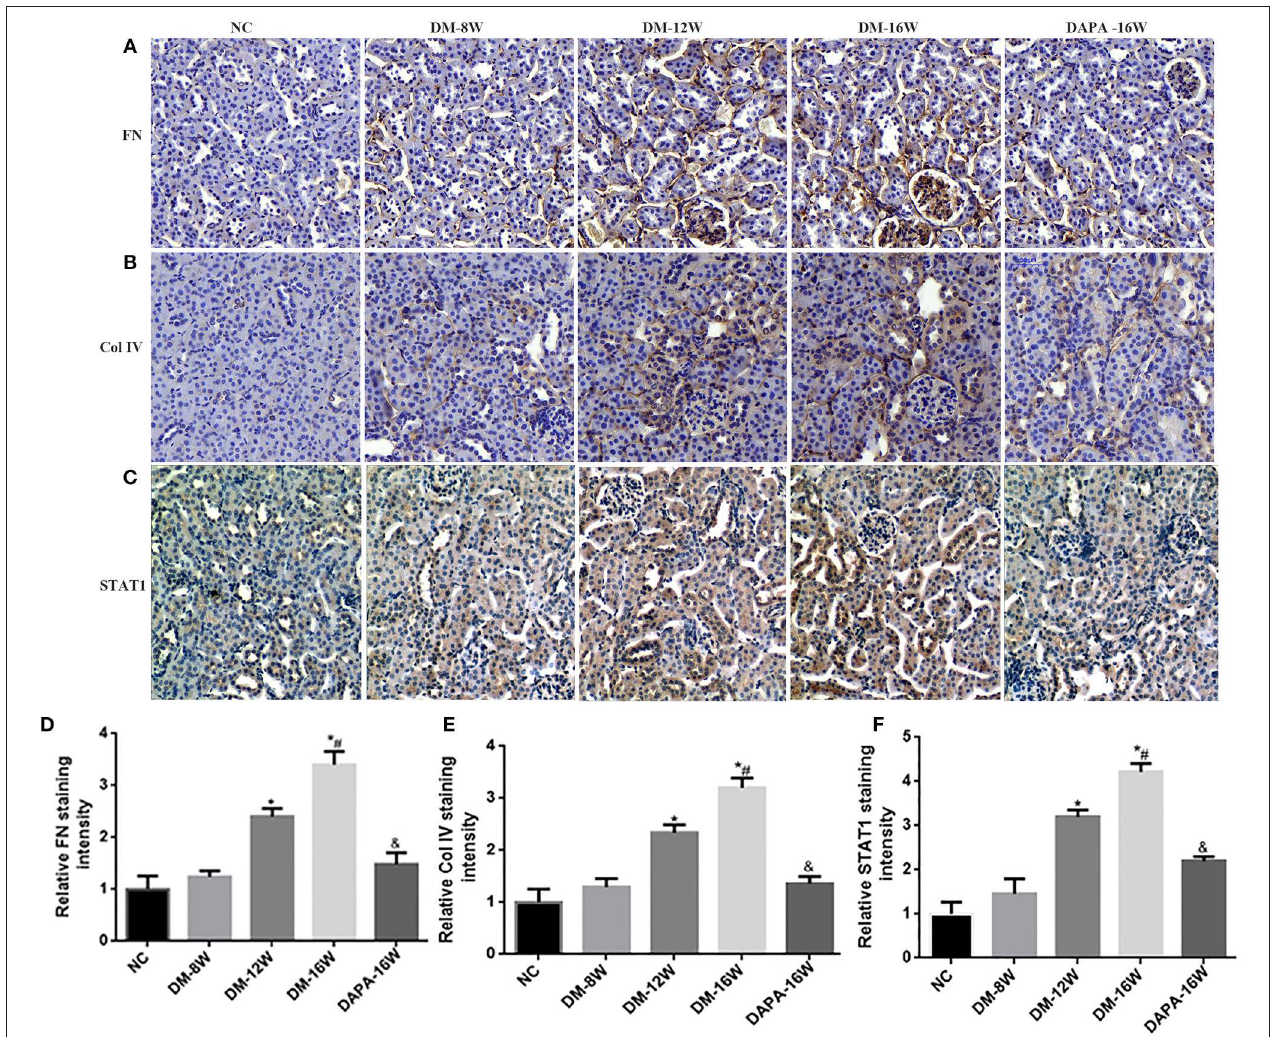
FIGURE 5 | Effect of DAPA on extracellular matrix (ECM) protein accumulation and renal TIF. (A–C) IHC examination of kidney sections for FN, Col IV, and STAT1. Original magnification, 200 × . (D–F) Quantification of FN, Col IV, and STAT1 staining. * P < 0.05 vs. NC; # P < 0.05 vs. DM-12W; & P < 0.05 vs. DM-16W. Values are means ±